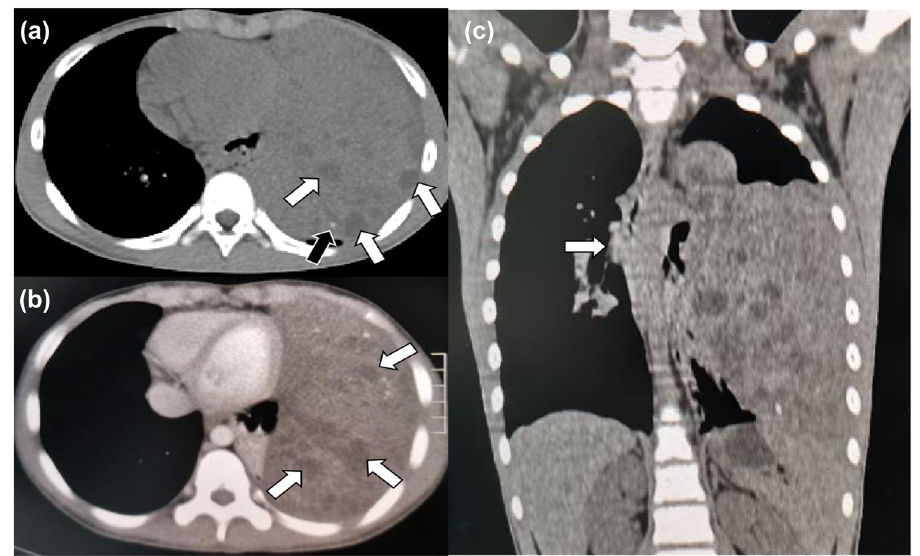
Figure 2: ( a ) Chest CT mediastinal window showed a huge soft - tissue density mass shadow in the left mediastinum, with unclear boundary, multiple nodular low - density areas ( black arrow ) , and speckled high - density calci fi cation foci ( white arrow ) . ( b ) Contrast - enhanced CT revealed mild heterogeneous enhancement of the lesion, with nodular nonenhanced necrotic area ( white arrow ) . ( c ) CT image of chest in coronal position. This coronal contrast - enhanced chest CT image clearly shows the extent of the mass, with the mediastinum slightly shifted to the right by the compression of the tumor ( white arrow )